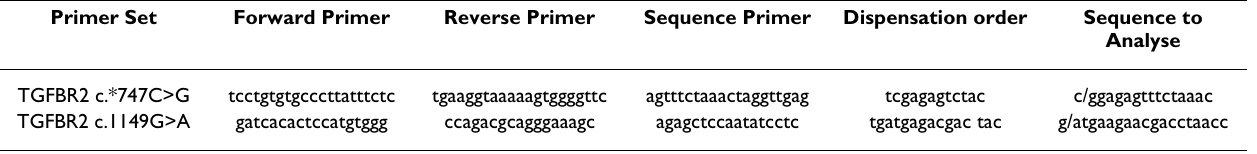
Table 5: Pyrosequencing primers, dispensation order and sequence to analyse for relevant assays Primer